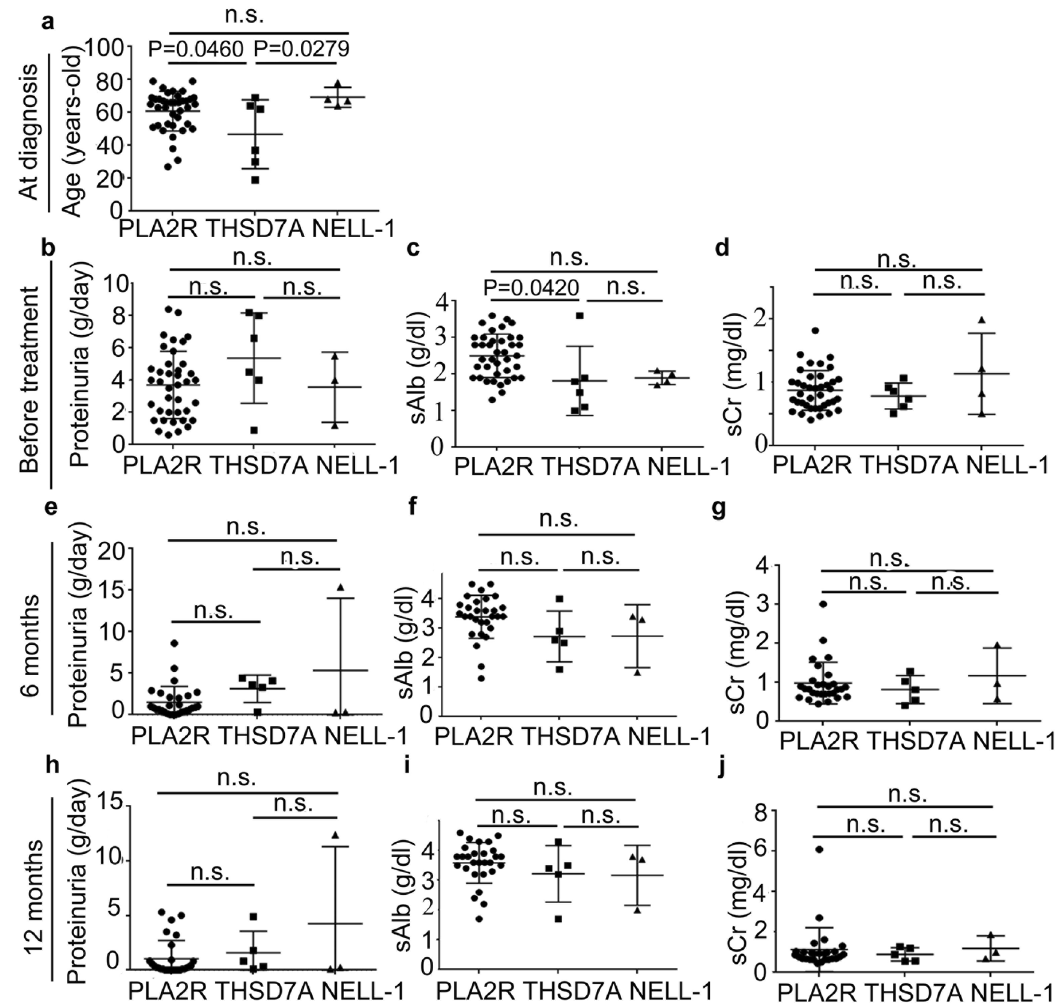
Figure 5. Changes in clinical parameters of each podocyte antigen-associated MN patients during the 1-year follow up. ( a ) Age at diagnosis. The levels of proteinuria ( b , e , h ), serum albumin ( c , f , i ), and serum creatinine ( d , g , j ) just before the treatment ( b , c , d ), at 6 months ( e , f , g ), and at 12 months ( h , i , j ) after starting treatment. sAlb serum albumin, sCr serum creatinine, n.s . not significance.